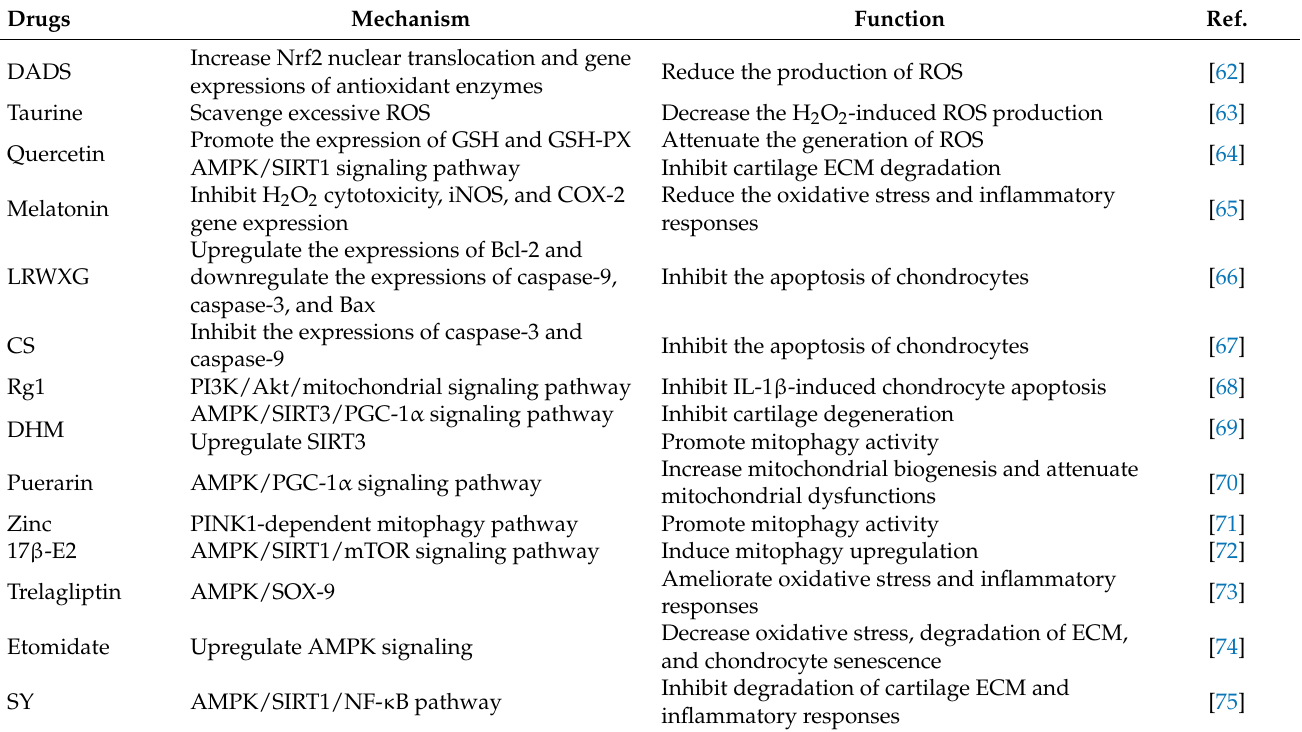
Table 1. Classifications and biological functions of drugs in